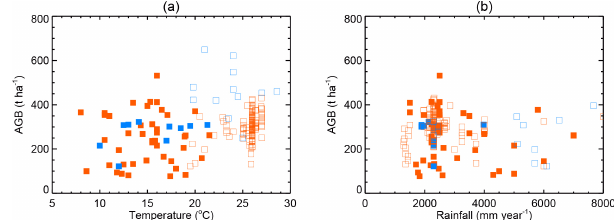
Figure 3. Relationship between AGB (land surface area) and an- nual mean (a) temperature, (b) rainfall (neotropics: red, Asia: blue). Solid points are for TMFs (elevation ≥ 1000m), open points are for lowland forests.